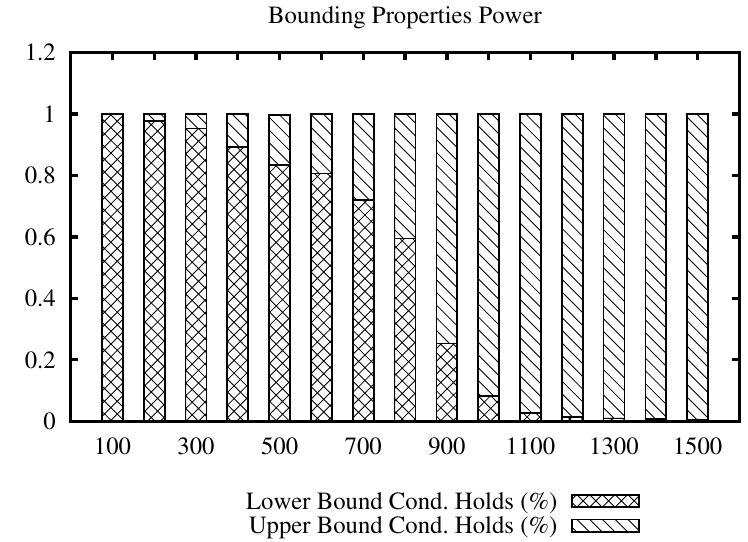
Figure 8. Percentage of filtering that each bounding property can achieve within the range of radius of the join algorithm using the ImgMedical data set with the Mahalanobis distance